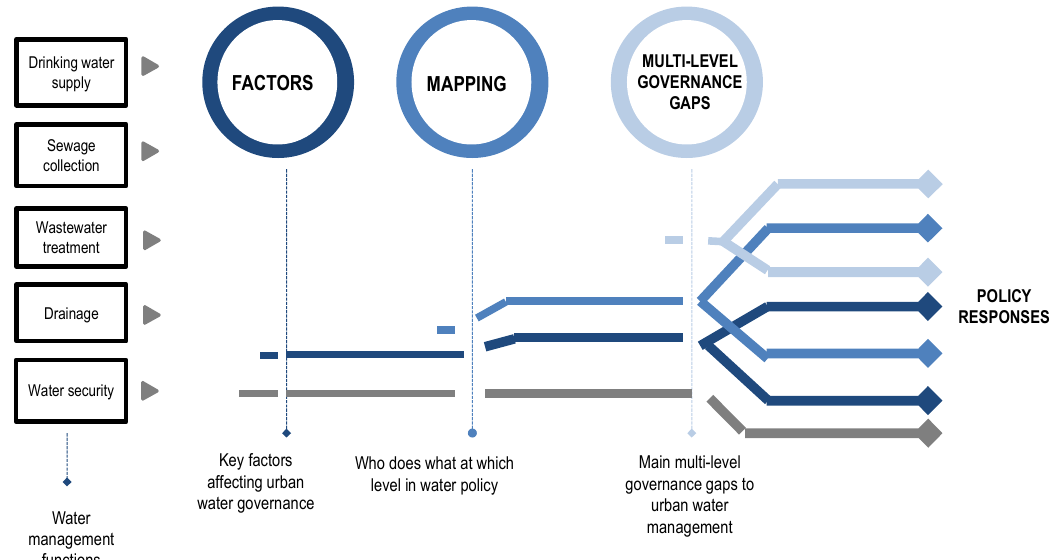
Figure 2. The analytical framework for assessing water governance in cities. Source: OECD (2016), Water Governance in Cities. OECD Publishing, Paris.